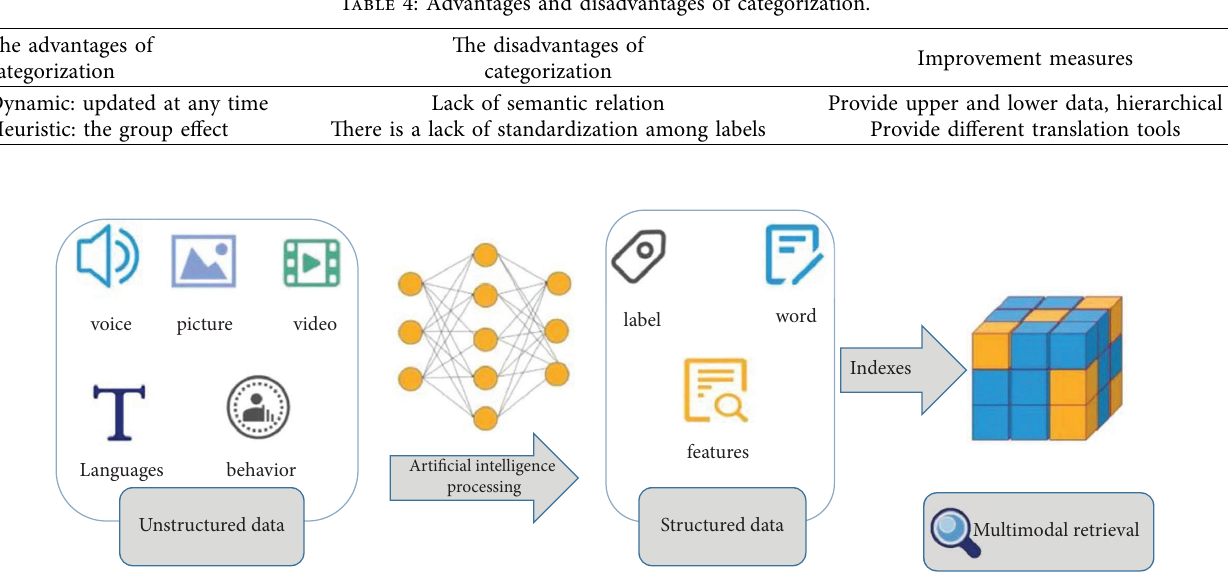
Figure 8: High-dimensional retrieval